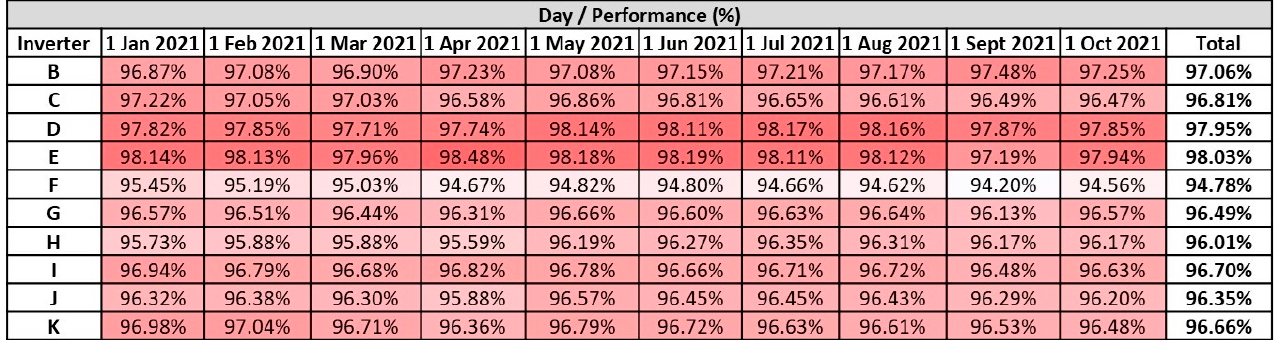
Figure 16. Inverter performance heat map (using red color conditional formatting) at STC over the evaluation period.